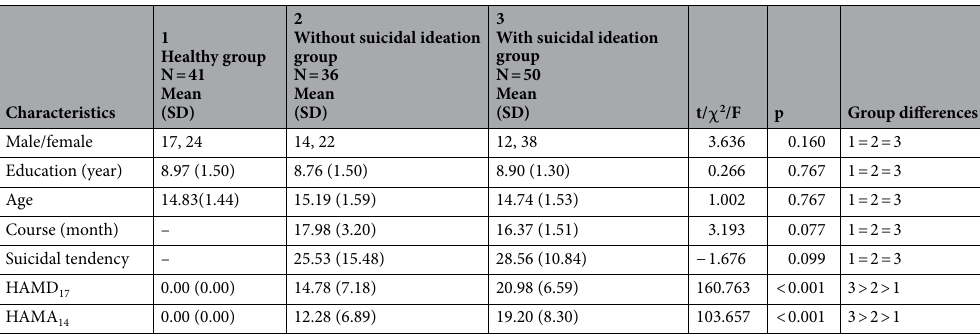
Table 1. Key demographic and clinical factors in the (1) healthy group, (2) without suicidal ideation group and (3) with suicidal ideation group. –: no relevant data, HAMD 17 Hamilton Depression Scale-17, HAMA 14 Hamilton Anxiety Scale-1.